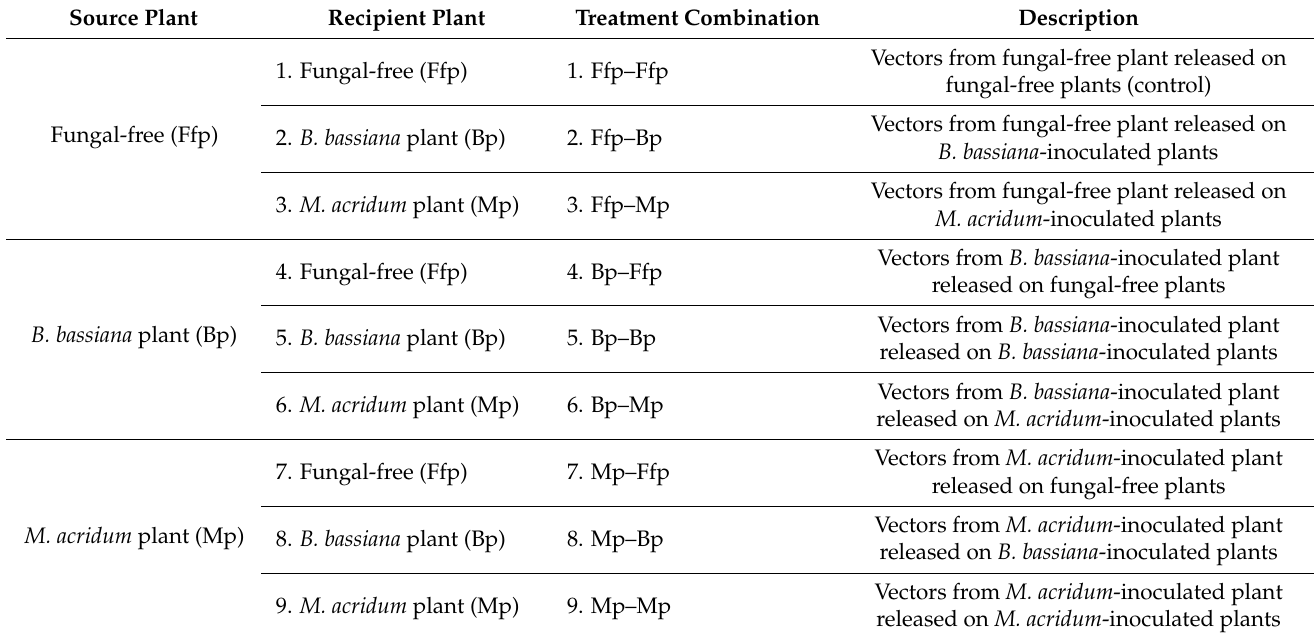
Table 2. Different treatment combinations in the virus spread